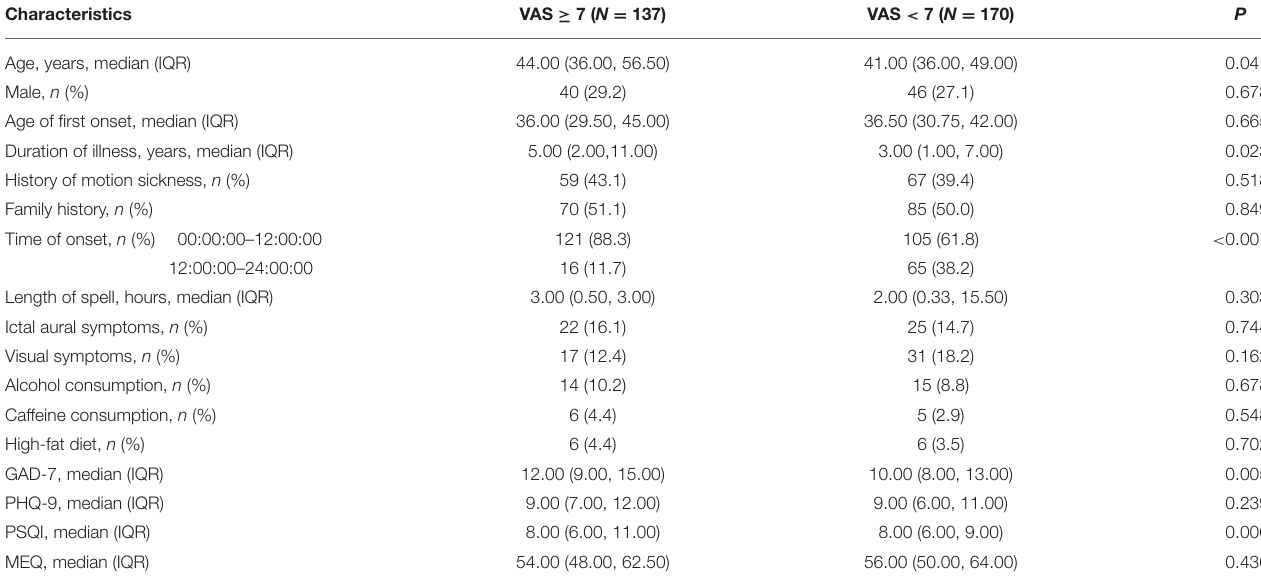
TABLE 3 | Comparison of demographic, clinical and psychometric characteristics between groups of VM patients with high and low VAS.